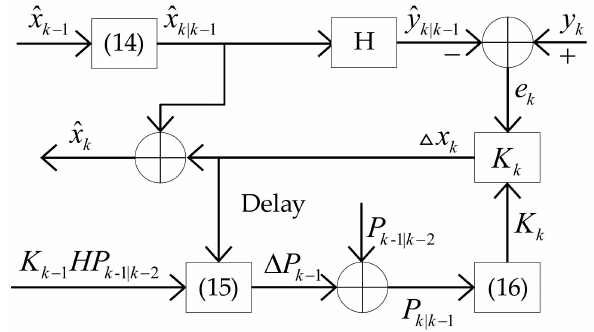
Figure 1. Calculation block diagram of new